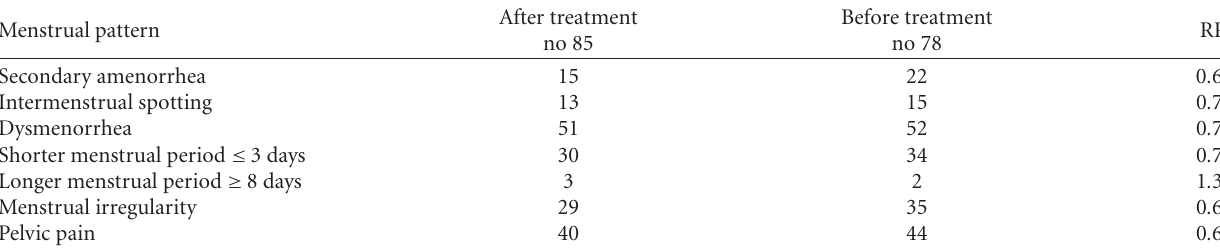
Table 2: Menstrual patterns in the patients with tuberculosis, before and after treatment. After treatment Before Menstrual pattern